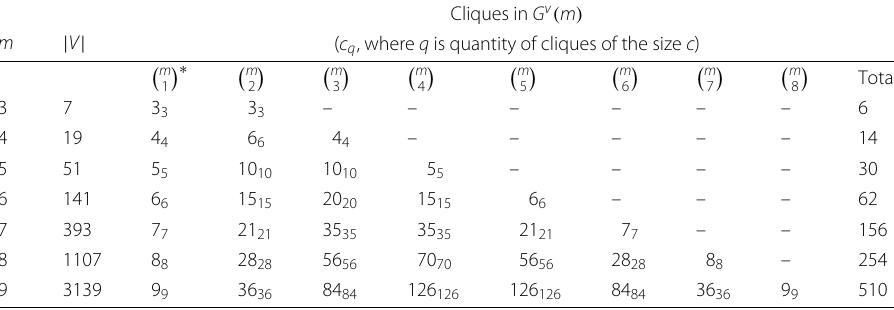
Table 2 The results of numerical calculation of the clique parameters (size and quantity) Cliques in G v ( m ) m | V | ( c q , where q is quantity of cliques of the size c ) (cid:2)